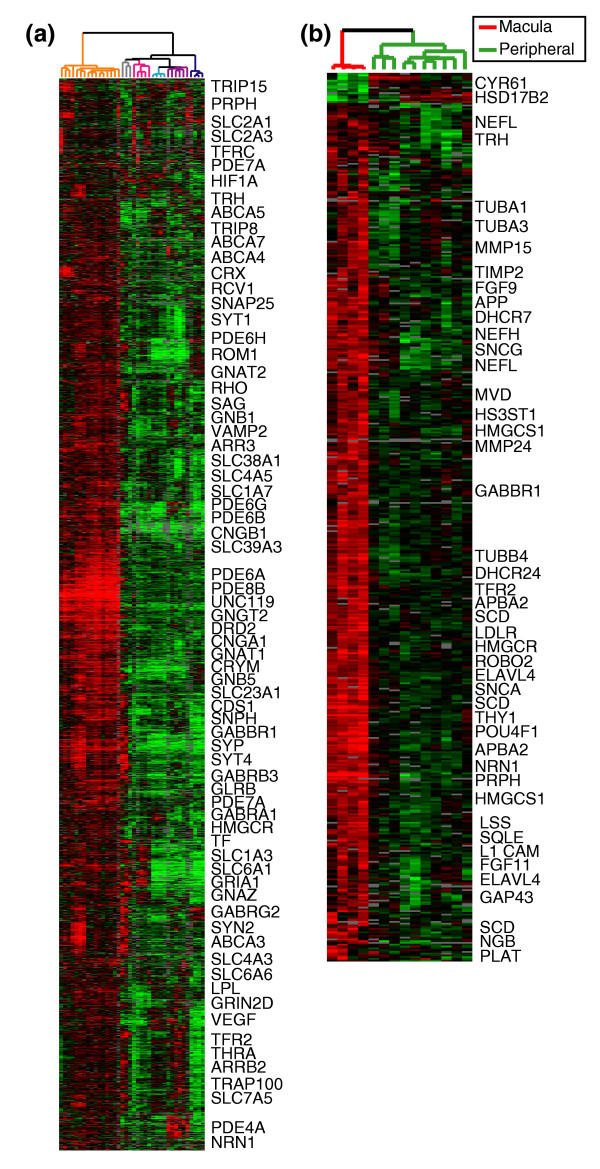
Retinal gene expression. (a) The retina-specific gene expression signature was extracted from Figure 1 and is displayed similarly. Many of the array elements encode uncharacterized genes and only a subset of named genes is shown. (b) Macula versus peripheral retina gene expression. Using the statistical analysis of microarrays algorithm as described in Materials and methods, we selected genes that differed significantly between the central and peripheral retinal arrays at a false discovery rate <0.05.